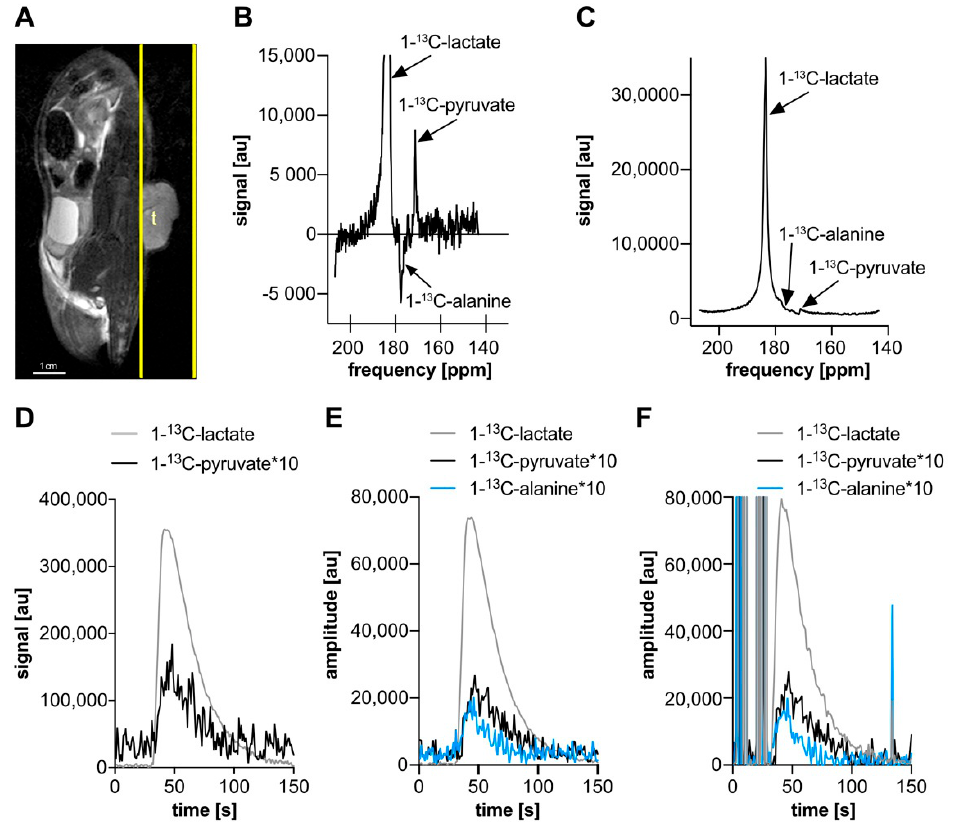
Figure 2. Broad bandwidth (5 kHz) excitation slice spectroscopy in a rat subcutaneous tumor after hyperpolarized [1- 13 C]lactate injection. ( A ) Representative sagittal T2-weighted (RARE) anatomical image of rat with tumor ( t ) and slice geometry (yellow outline). ( B , C ) Spectra summed over 13 frames (26 s) covering the [1- 13 C]pyruvate signal maximum. ( B ) Real part of manually phased complex spectrum with zoomed signal range to show smaller peaks and background. The lactate peak is narrower than in ( C ), but determining phase factors to remove background signal at the alanine and pyruvate peak center frequencies is difficult, affecting their quantification. ( C ) Magnitude spectrum in which the tail of the lactate spectral peak (centered near 183.5 ppm) is comparable in magnitude to the pyruvate (near 171 ppm) and [1- 13 C]alanine (near 177 ppm) at their central frequencies, and the peaks interfere with each other, distorting the shape of the lactate peak tail. ( D ) Time course of the lactate and pyruvate spectral peak magnitudes, before and after lactate injection (near 30 s). ( E , F ) Time course of AMARES lactate, alanine, and pyruvate fit magnitudes with highly ( E ) and lightly ( F ) constrained models. Early time-point fits before lactate injection have implausible and highly variable amplitudes in the lightly constrained model. Between these models, the lactate time course appears different near its peak, and the alanine and pyruvate curves appear to have a higher mean value at later times (> 90 s) in the highly constrained